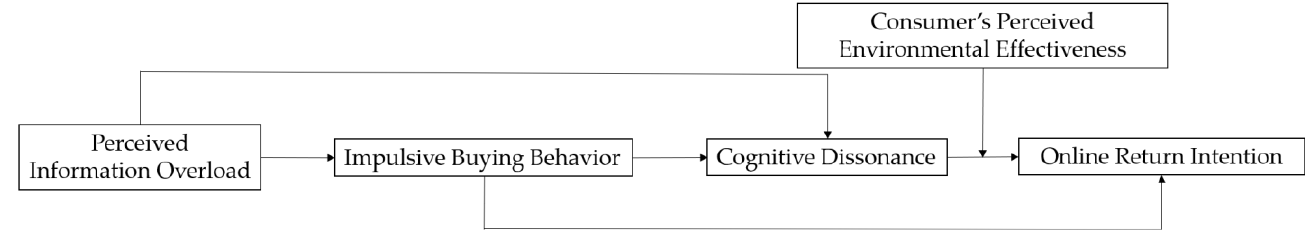
Figure 1. Theoretical research model.